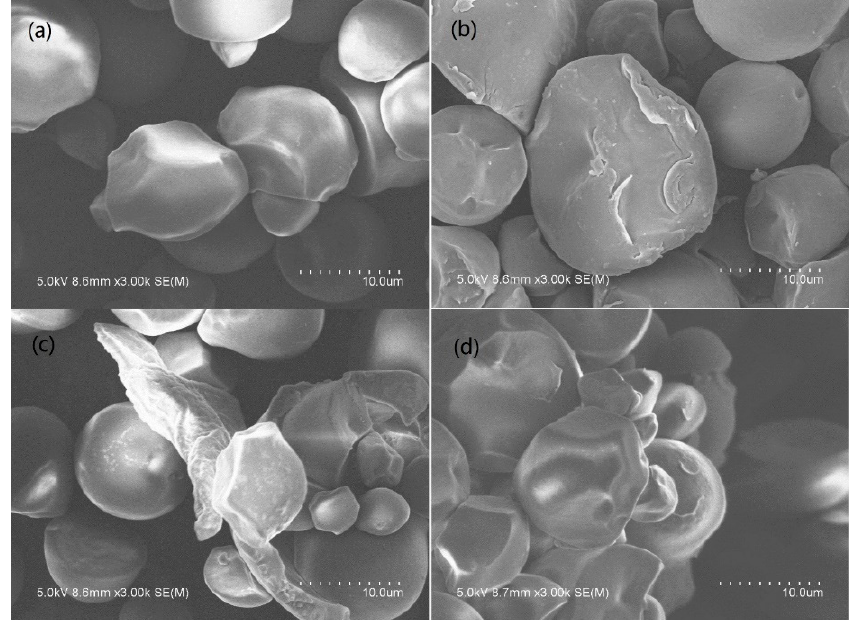
Figure 2. Scanning electron microscopy (SEM) images of OTS ( a ) and QHOTS with degree of substitution (DS) values of 0.014 ( b ), 0.026 ( c ) and 0.033 ( d ).